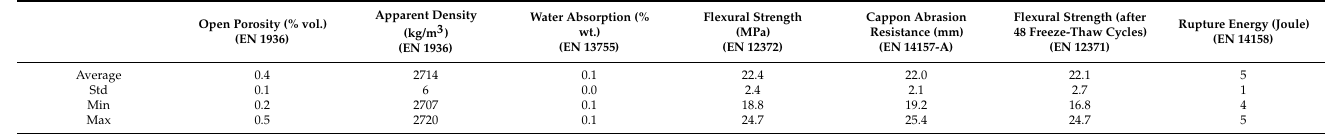
Table 8. Average values of physical mechanical properties determined for slate—cipollino marbles.